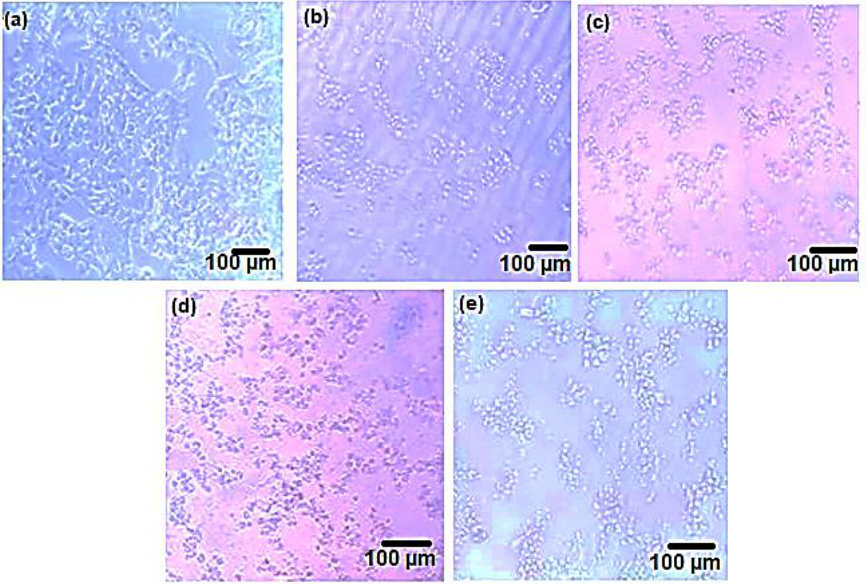
Figure 6. In vitro cytotoxicity microscopic observations of RPMI 2650 cells after 72 h of treatment ( a ) control, ( b ) MEM 1000 μg /mL, ( c ) MEM 500 μg /mL, ( d ) MEM- NC3 1000 μg /mL, and ( e ) MEM- NC3 500 μg /mL.